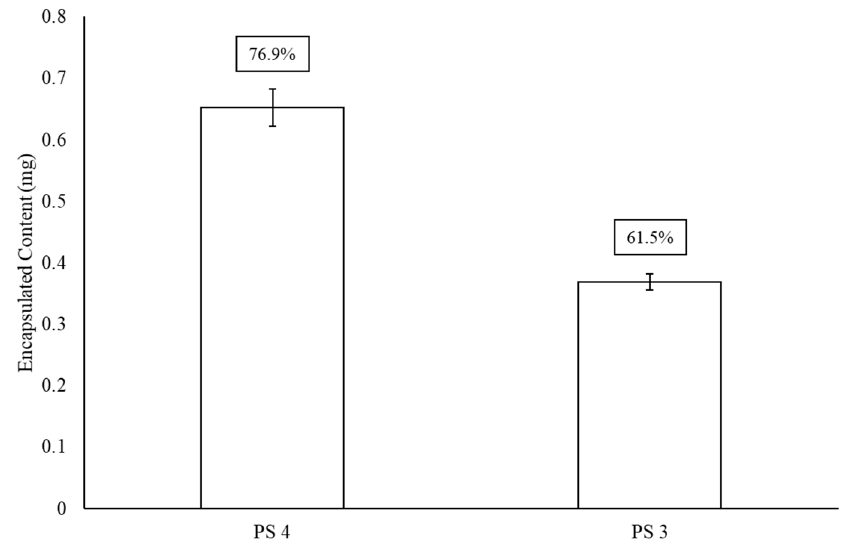
Figure 3. LEPS encapsulation e ffi ciency (boxed values) of polysaccharides (PS) 4 and 3 after GFP protein surface